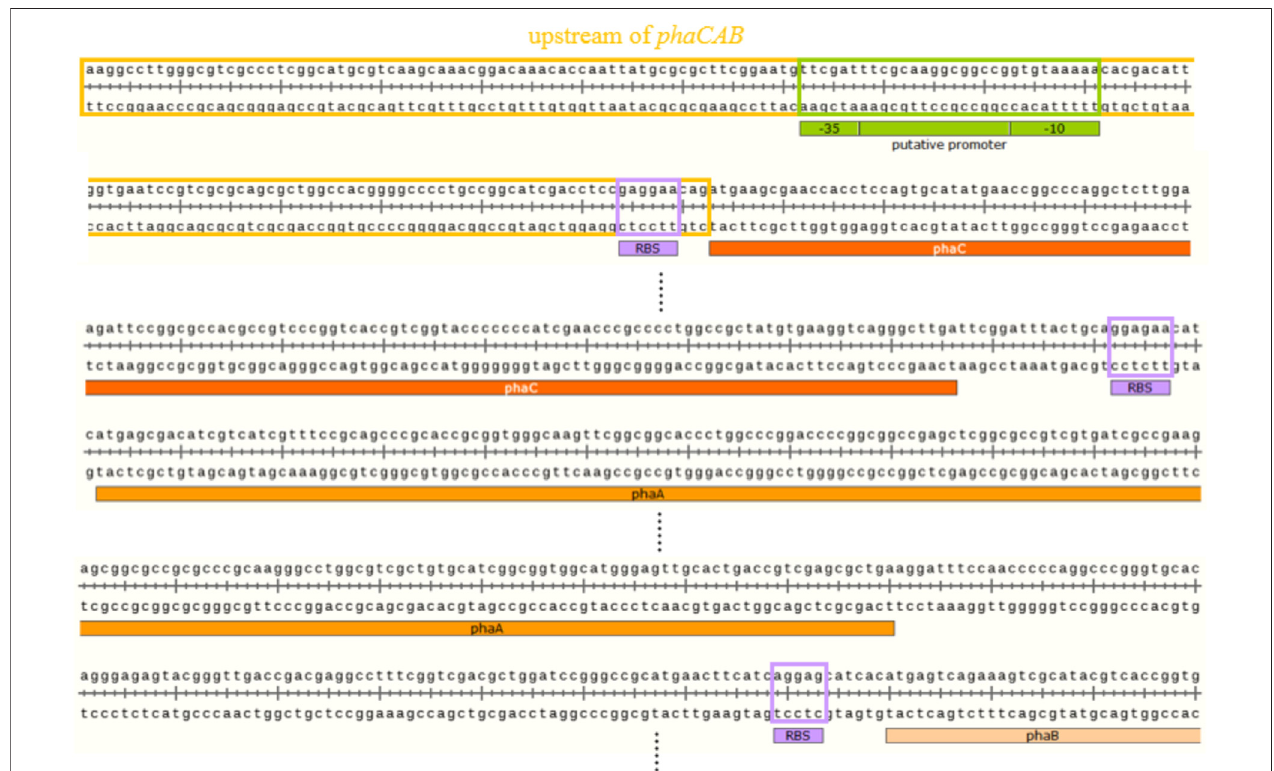
FIGURE 5 | The putative promoter of phaCAB operon and the putative ribosome binding sites (RBSs) of phaCAB genes.